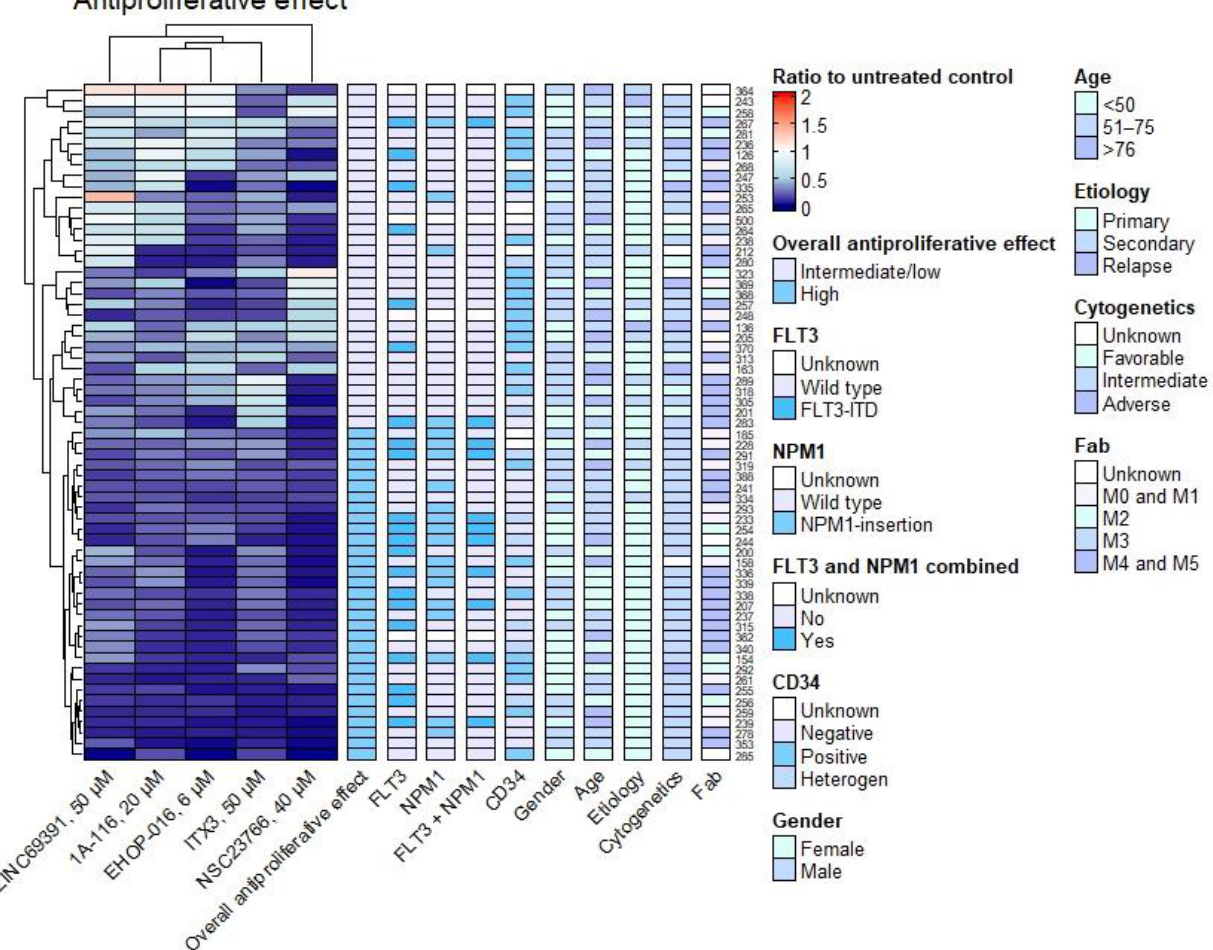
Figure 4. Rac1 inhibition has an antiproliferative effect. Proliferation is shown as the ratio of treated cells to the untreated control after seven days of culture. Each row is a patient sample, and each column in the heatmap is a Rac1 inhibitor. The heatmap is made with Euclidean clustering and complete linkage. Patient mutational status and CD34 status of the leukemic blasts are indicated on the right side of the heatmap, along with patient characteristics. The high overall antiproliferative effect of the inhibitors was more common in NPM1 -mutated ( p = 0.002) and CD34-negative ( p = 0.008) samples, as well as samples with combined NPM1 and FLT3 mutations ( p = 0.027) using Fisher’s exact test.